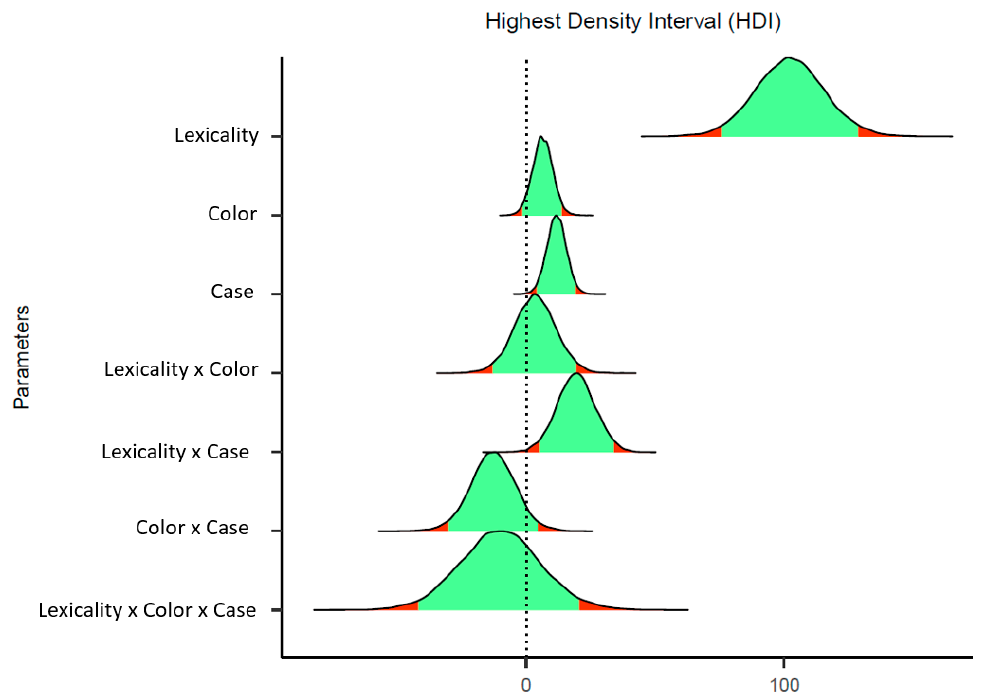
Figure 1. Posterior distributions from the Bayesian linear mixed-effects models for each of the effects. The red area reflects the parameter values beyond the 95% Credible Intervals.